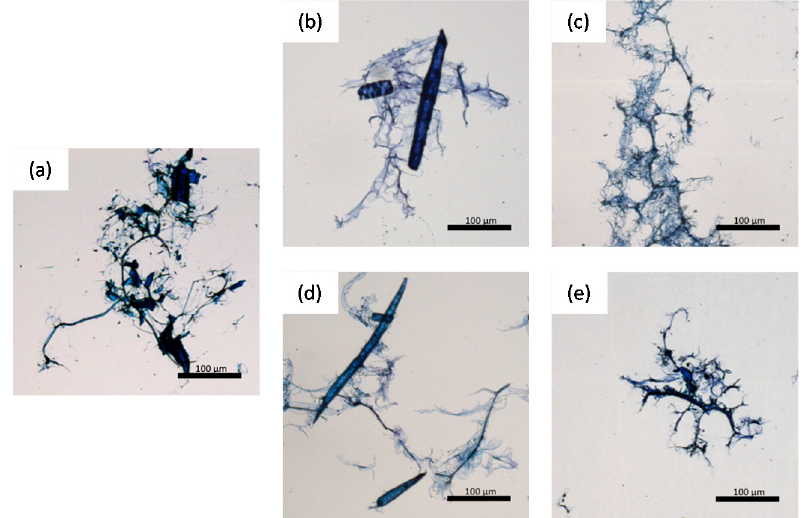
Figure 4. Optical microscopy images of ( a ) MP fines; ( b ) UB PF kraft pulp; ( c ) UB SF kraft pulp; ( d ) B PF sulfite pulp; ( e ) B SF sulfite pulp.